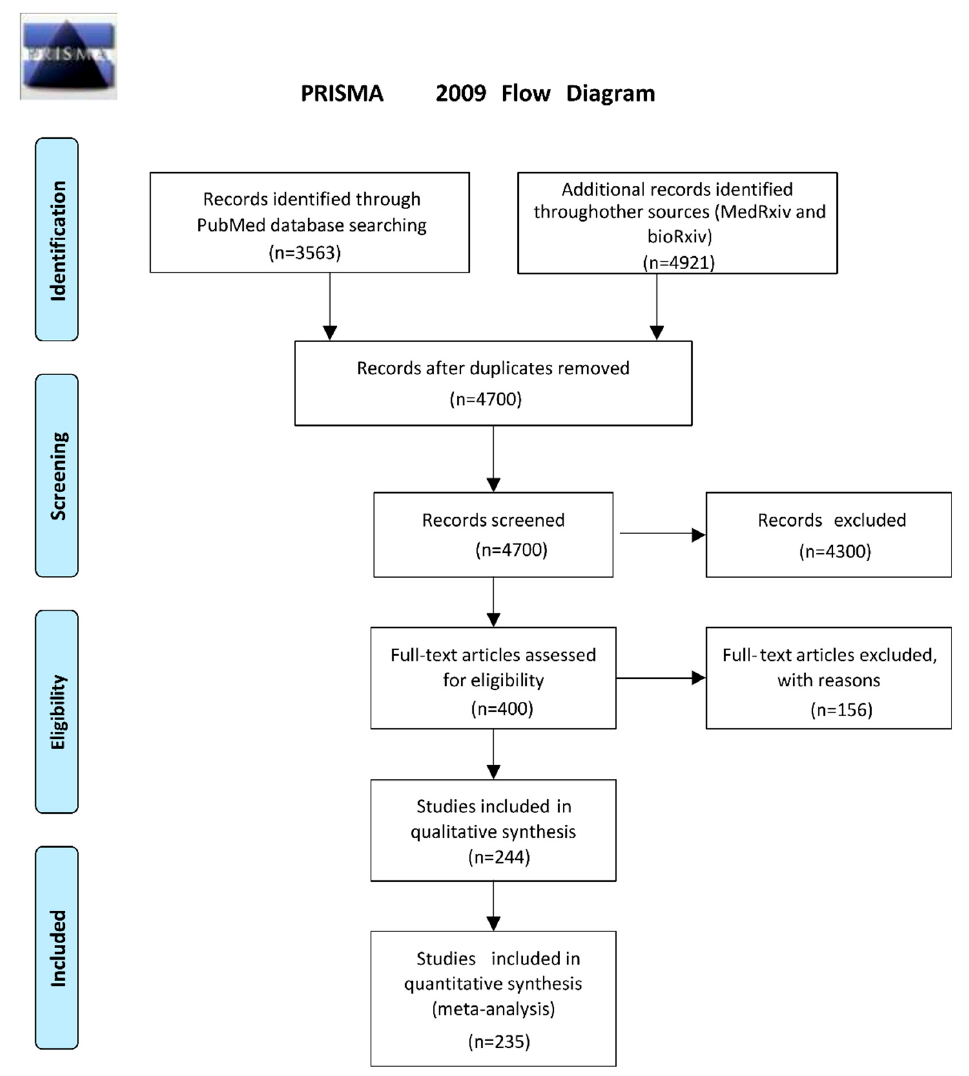
Figure 1. Preferred Reporting Items for Systematic Reviews and Meta-Analyses (PRISMA) flow diagram.